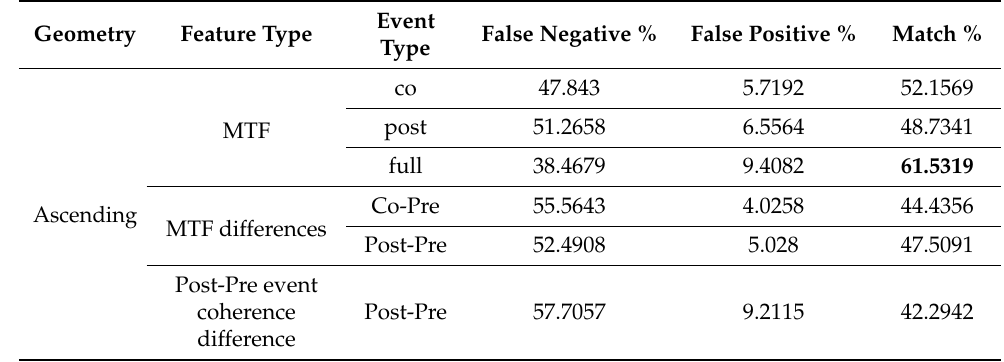
Table 2. Results of classification on ascending geometry data. (The best match is marked in bold text).